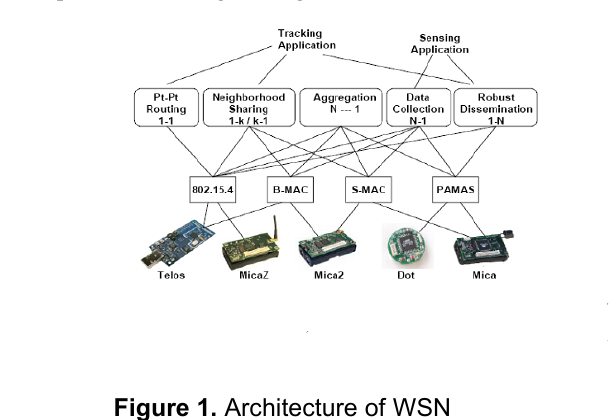
Figure 1. Architecture of